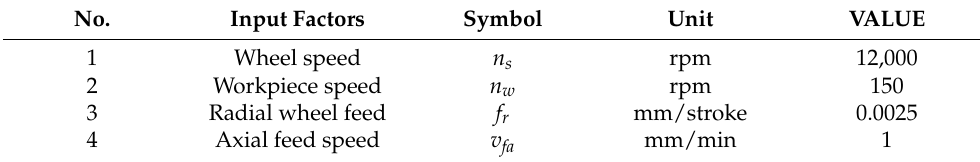
Table 2. Input parameters of the grinding process.